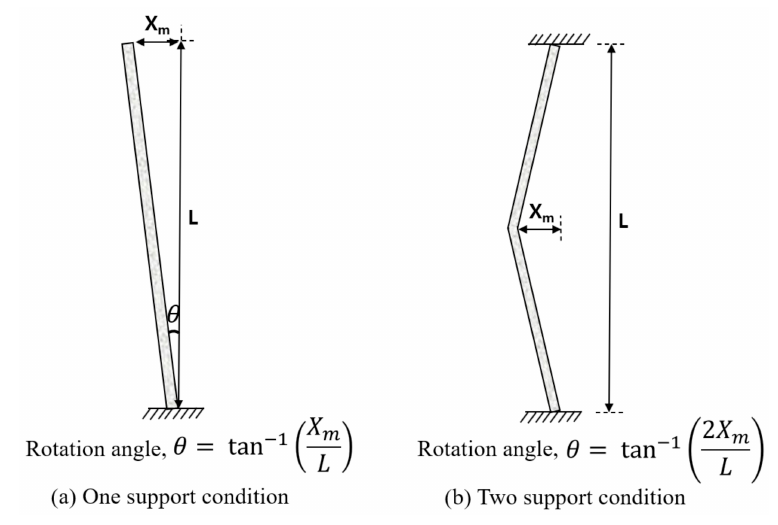
Figure 3. Rotation angle at its supports. Table 1. Design consideration of the protective